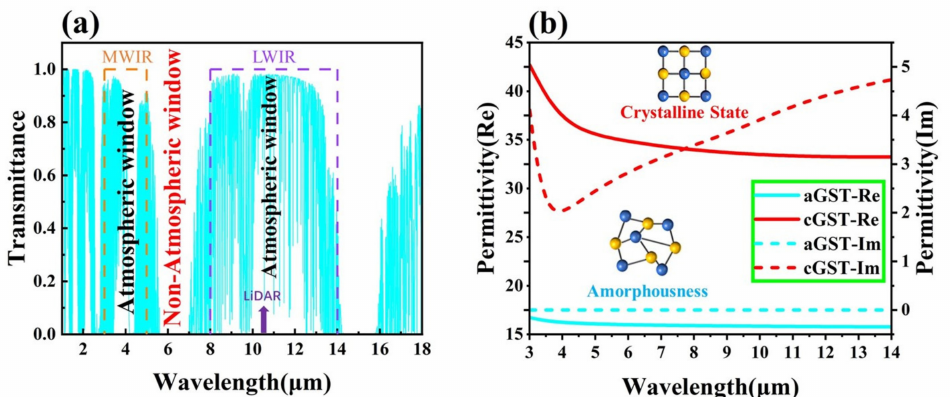
Figure 2. ( a ) Atmospheric transmission spectrum in the infrared band, schematic diagram of the LiDAR absorption band and the band where the atmospheric window is located. ( b ) Dielectric constants of crystalline GST and amorphous GST in the infrared